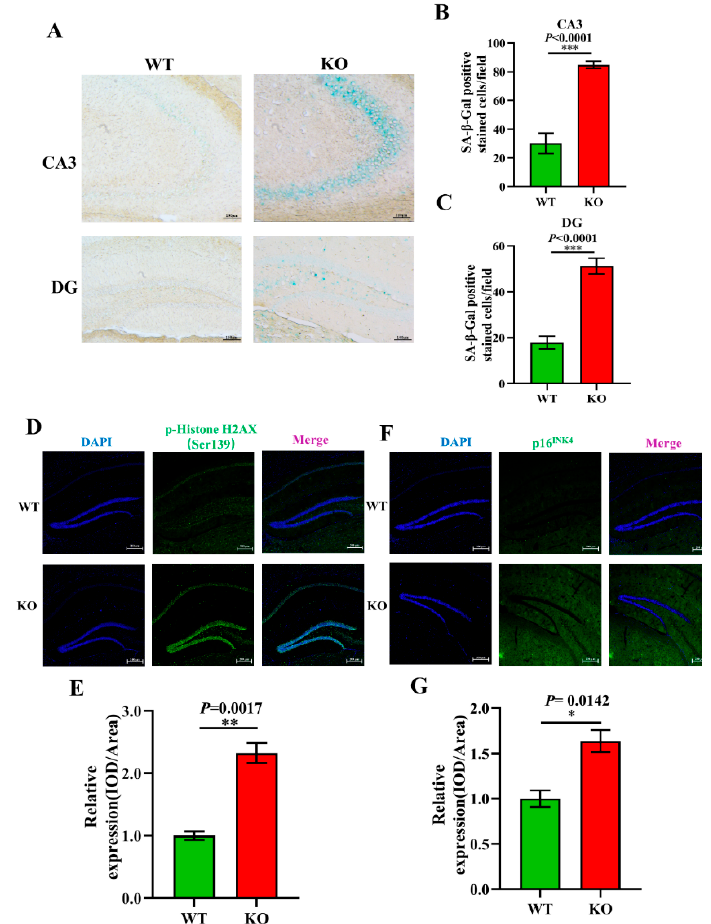
Figure 5. Atp11b -KO mice display aging pathology. ( A ) SA- β -Gal staining of the mouse hippocampus. ( B ) Quantitation of the SA- β -Gal-positive cells in the CA3 region. ( C ) Quantitation of SA- β -Gal expression in the DG region. Scale bars: 100 μ m; for each group of mice, n = 4. ( D ) p-HistoneH2AX (green) fluorescence staining of the mouse hippocampus. ( E ) Average fluorescence intensity of p-HistoneH2AX in the mouse hippocampus. ( F ) p16 INK4 (green) fluorescence staining in the mouse hippocampus. ( G ) Mean fluorescence intensity of p16 INK4 in the mouse hippocampus. Scale bars: 200 μ m; for each group of mice, n = 3. The mice were 12 months old; data are expressed as the mean ± SEM. Student’s t -test, * p < 0.05, ** p < 0.01, *** p < 0.001.